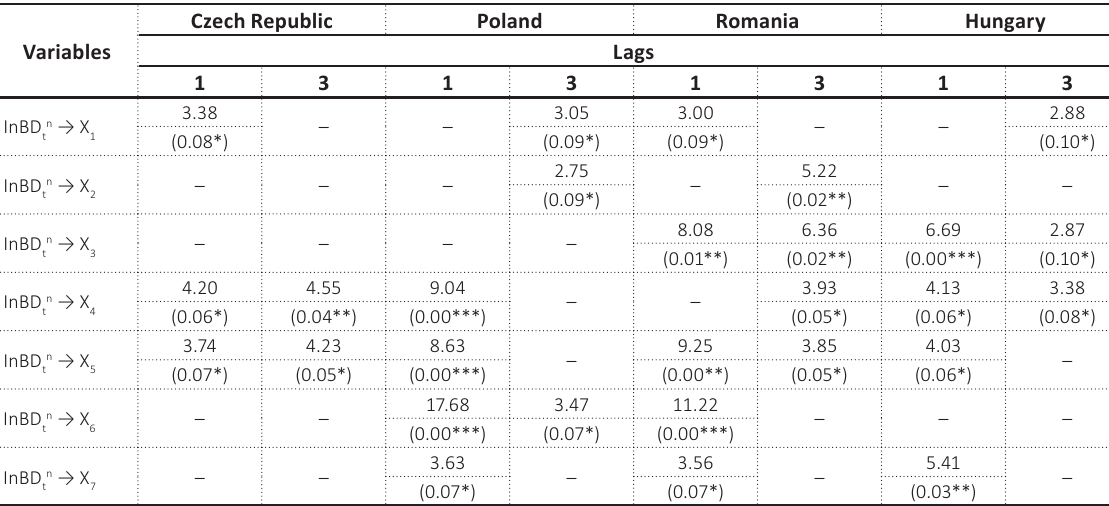
Table 4. Mutual causality of parameters of economic growth and the banking sector development of some EU countries, 2000–2019